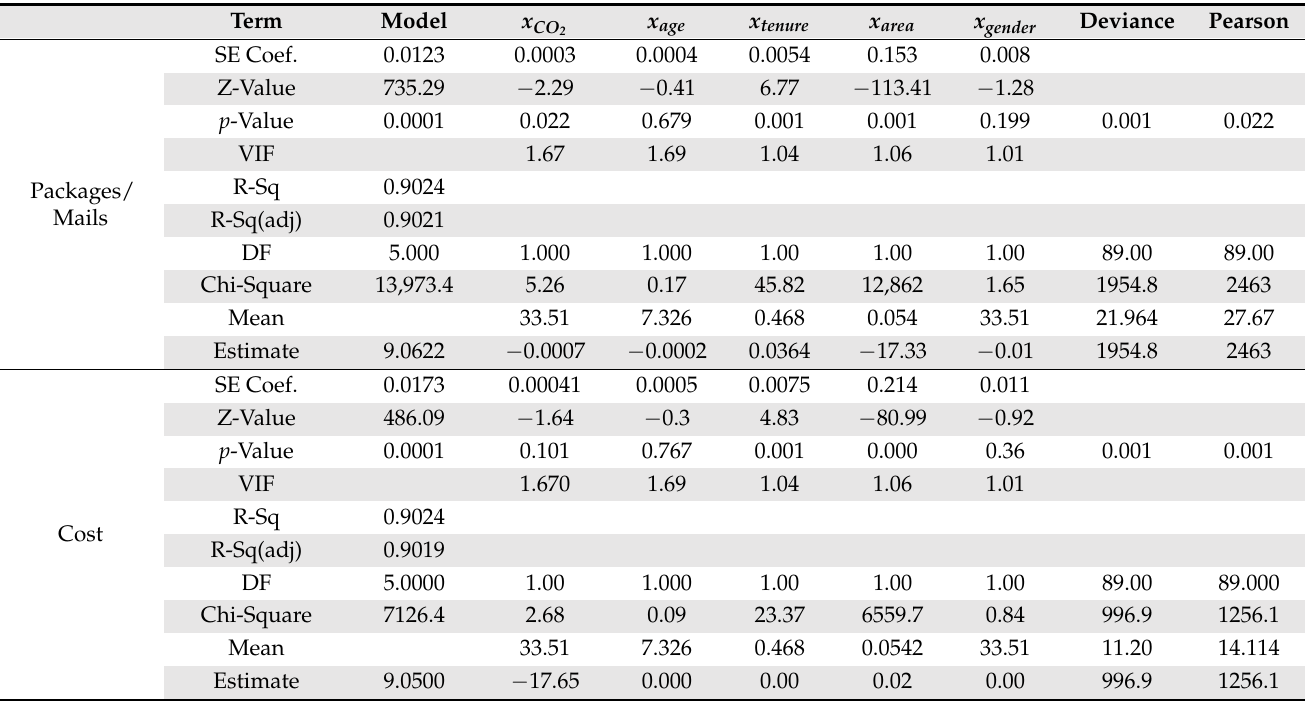
Table 4. Poisson distribution regression analysis data of the e-scooter distribution.